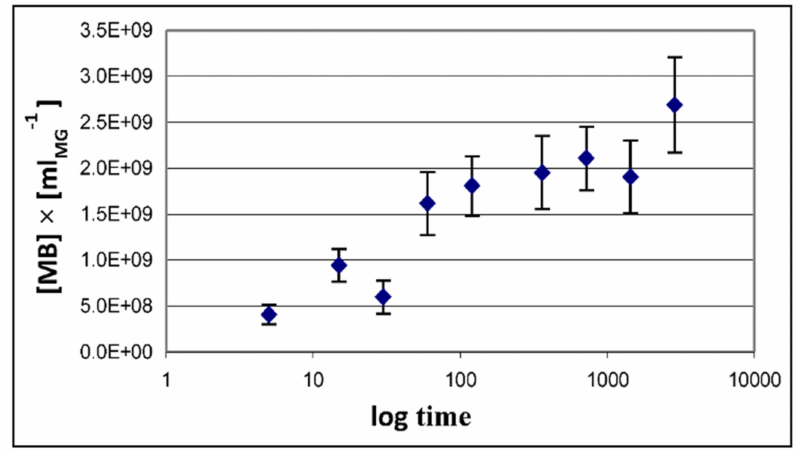
Figure 27. Nine 100 mL samples of 0.2 µ m-filtered seawater were incubated for 144 h. to produce self assemble gels. Each sample was then inoculated with bacteria isolated by filtration from seawater collected from the dock of Friday Harbor Laboratories and incubated at 10 ◦ C. MB growth was then se- quentially arrested in samples 1 through 9 every 80 min by exposure to 1 mM NaN3, and fluorescently tagged with CTC to label MG and BacLight Red to label MB. Each sample was then immediately filtered using 0.1- µ m black Nucleopore filters. Filters were mounted in a Nikon fluorescence confocal microscope. Images of four fields captured at 1200 × magnification, covering 60–80 µ m 2 each were randomly selected and recorded from each filter containing fluorescently labeled gels and bacteria found on the surface of the filter. MB lodged inside gels were counted in 300-nm confocal sections of MG. The points are the average ± SD of 256 sections in 16 microgels collected in each filter. Although the concentration of bacteria in seawater remained at ~2 × 10 6 –9.2 × 10 6 bacteria × mL − 1 , within few minutes the concentration of bacteria inside microgels equilibrated with the bacterial concen- tration in seawater and then increased exponentially with time from ~2.8 × 10 6 bacteria × mL − 1 of gel to ~2.7 × 10 9 bacteria × mL − 1 of gel. Points are the average ± s.d. of 36 sections in 12 microgels collected in each of the nine filters corresponding to successive 80 min arrest of bacterial